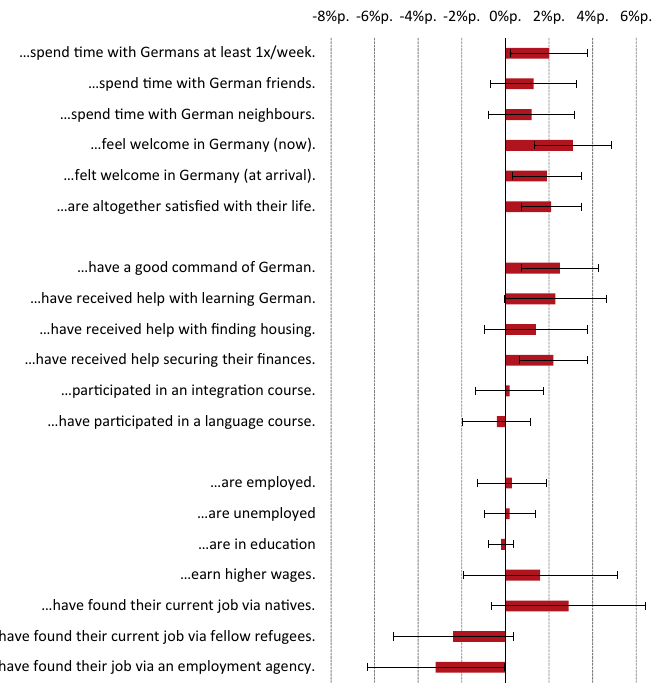
Figure 2: Relationship between local civic engagement and indicators for social integration Source: IAB-BAMF-SOEP Refugee Survey, 2016 – 2019, own calculations. Example: A refugee living in a region with a more engaged civil society (measured as